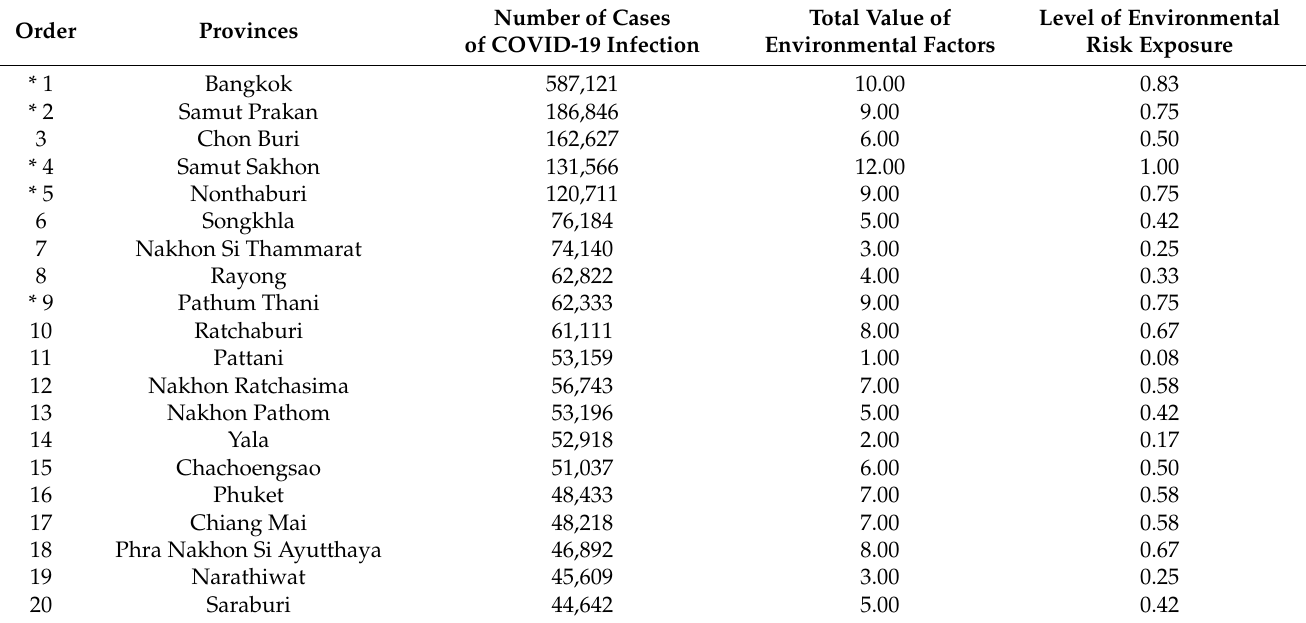
Table 2. Number cases of COVID-19 infection, total value of environmental factors, and level of environment risk exposure in twenty provinces of